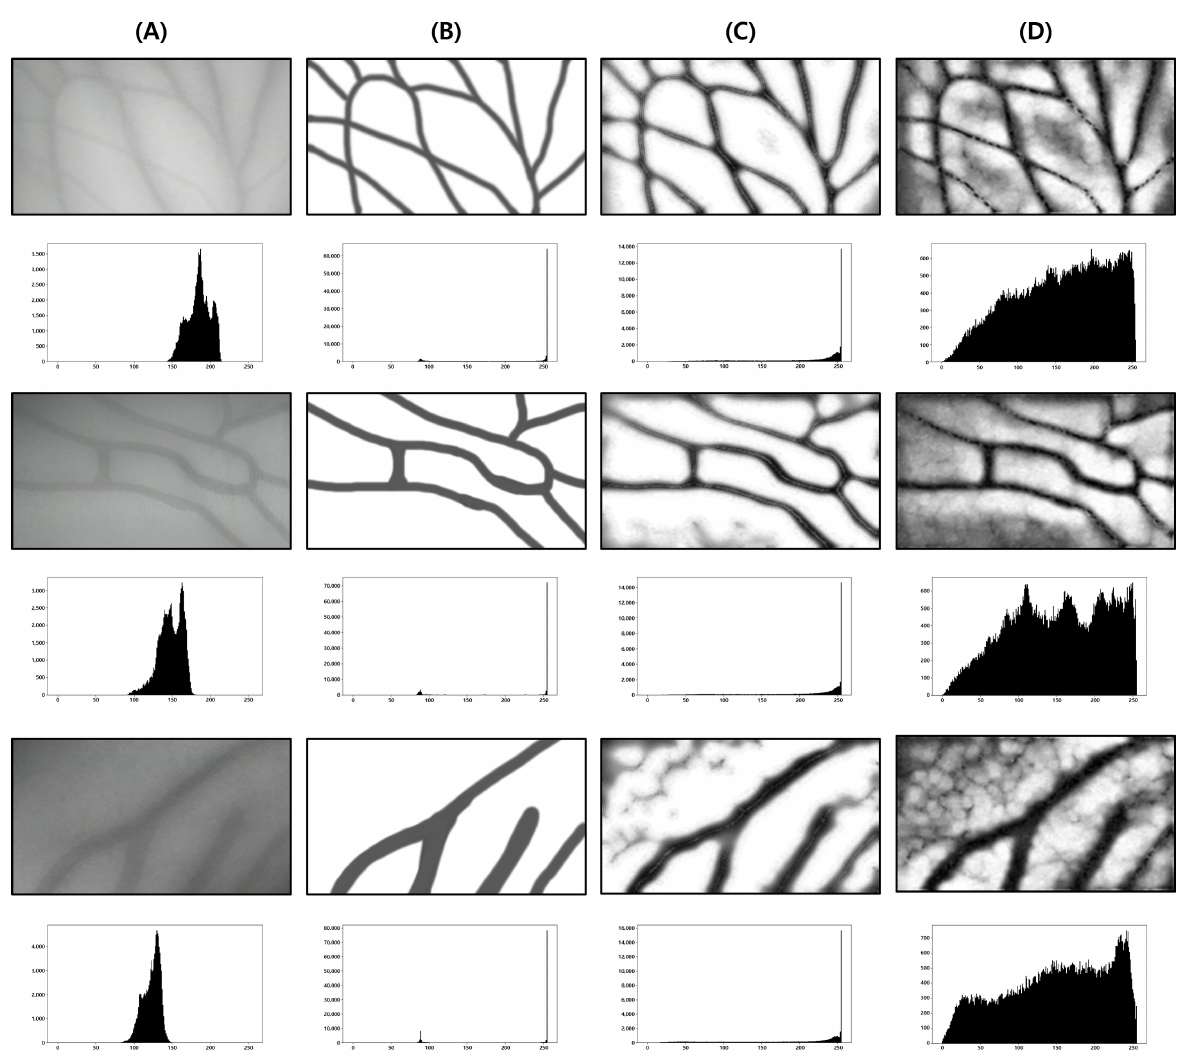
Figure 18. Image operation results without body hair noise: ( A ) is a test image created for algorithm verification, and ( B ) is an artificial blood vessel layer used to create the image. ( C ) is the resultant image of the proposed vein image processing algorithm, and ( D ) is the resultant image of the Veinvu-100 algorithm.